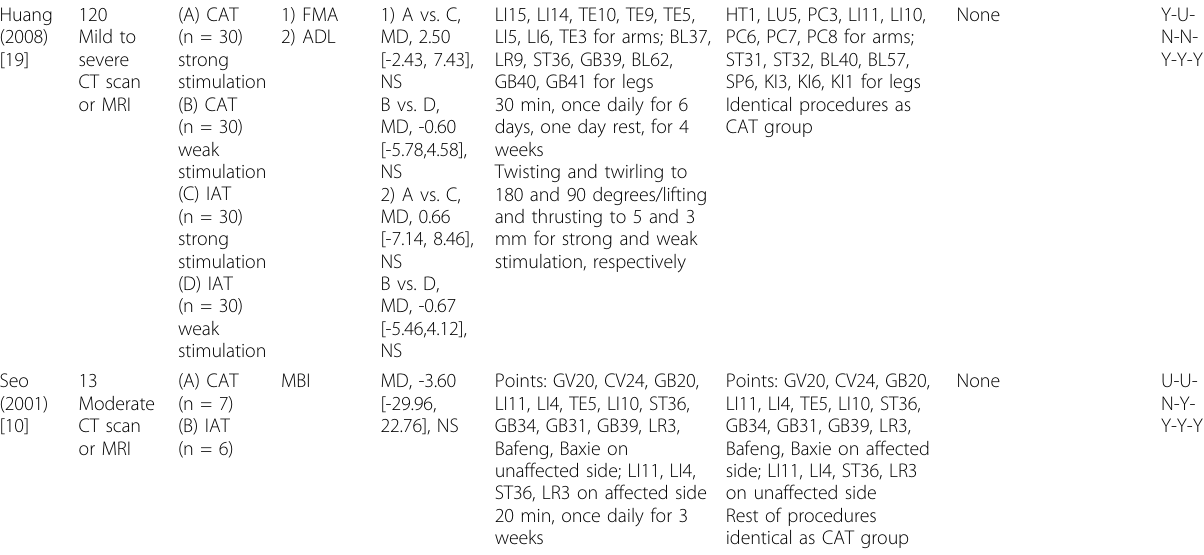
Table 1: Key data from RCTs comparing contralateral acupuncture (CAT) to ipsilateral acupuncture (IAT) in post-stroke hemiplegic patients